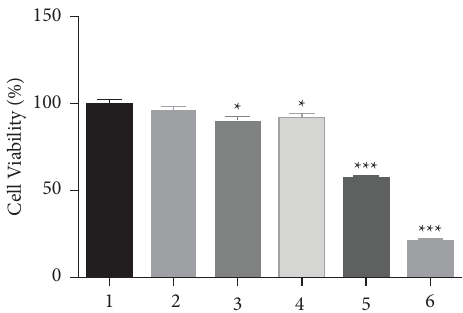
Figure 8: MTTassay. From left to right, the SLC concentrations were 0, 0.2, 0.5, 1, 2, and 4g/L in turn. Each group was treated with the SLC for 48h ( ∗ P < 0 . 1 and ∗∗∗ P < 0 . 001). Te cell viability of group 6 reached a plateau at ∼